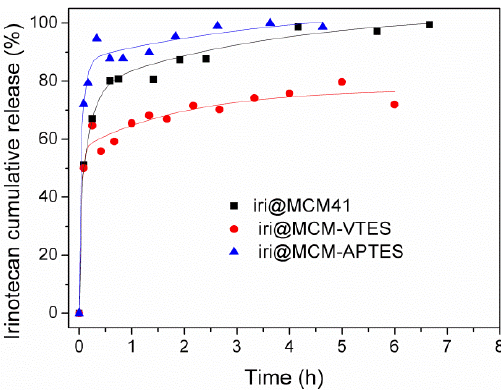
Figure 4. The cumulative release of irinotecan in PBS, pH =